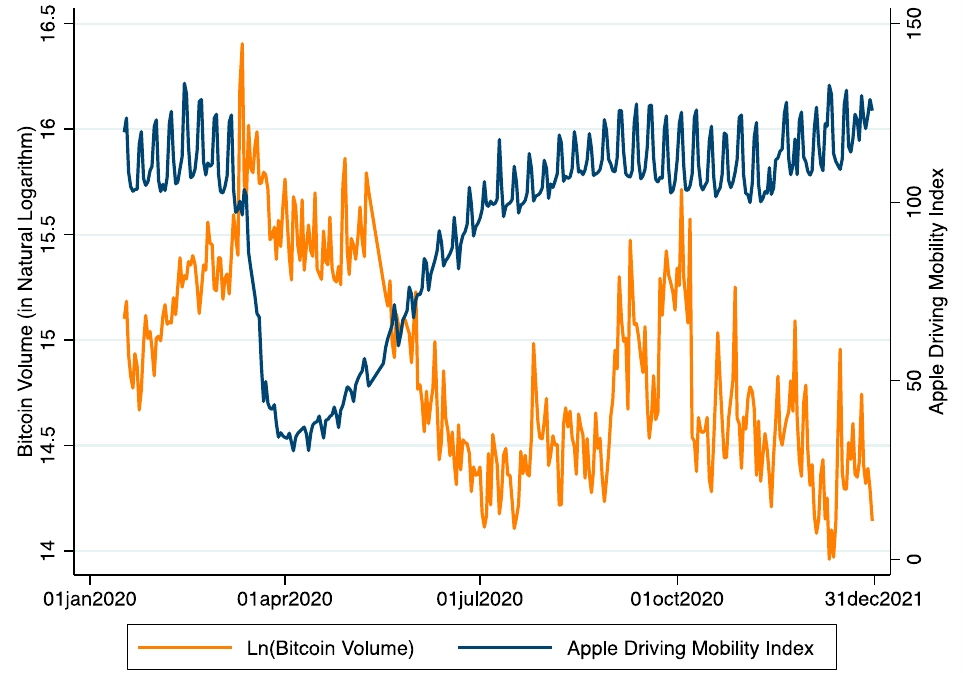
Figure 1. This figure represents the evolution of the natural logarithm of total Bitcoin trading vol- ume (axis on the left) and the Apple driving mobility index (axis on the right) and between 13 Jan-